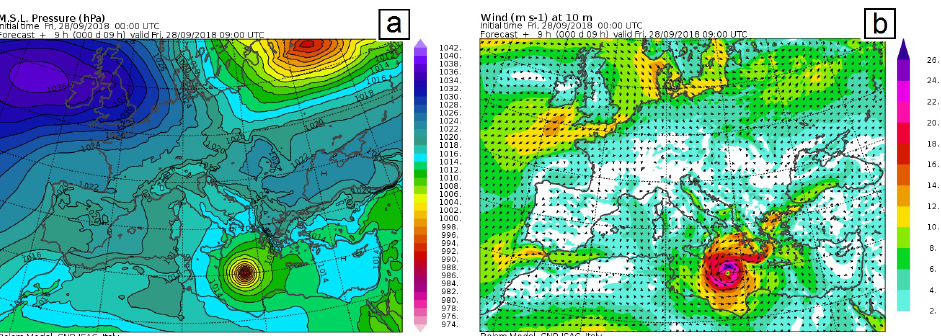
Figure 10. 28 September 2018 09:00 UTC: ( a ) Surface Pressure (hPa); ( b ) Wind (m/s) at 10 m (Bolam